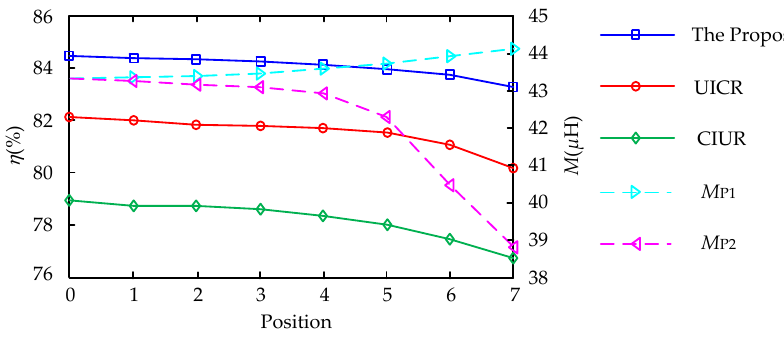
Figure 16. The efficiency of IPT system at various positions under constant load.